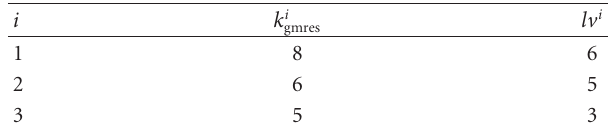
Table 5: Convergence history of Algorithm SI. Δ τ SI = 0 . 016. On